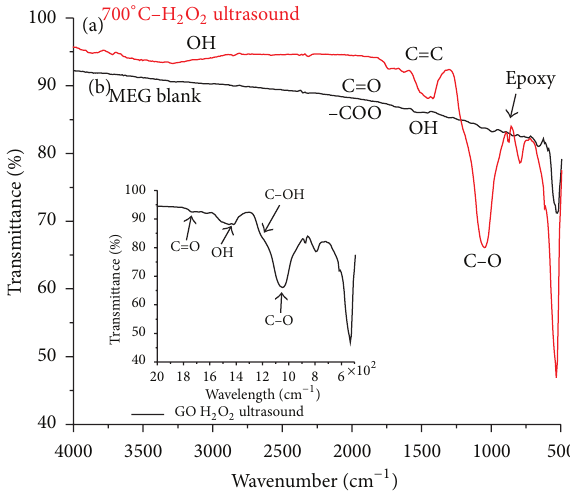
Figure 6: FT-IR spectra: (a) thermally pretreated graphene oxide plates in peroxide solution and ultrasonic vibration and (b) MEG blank.